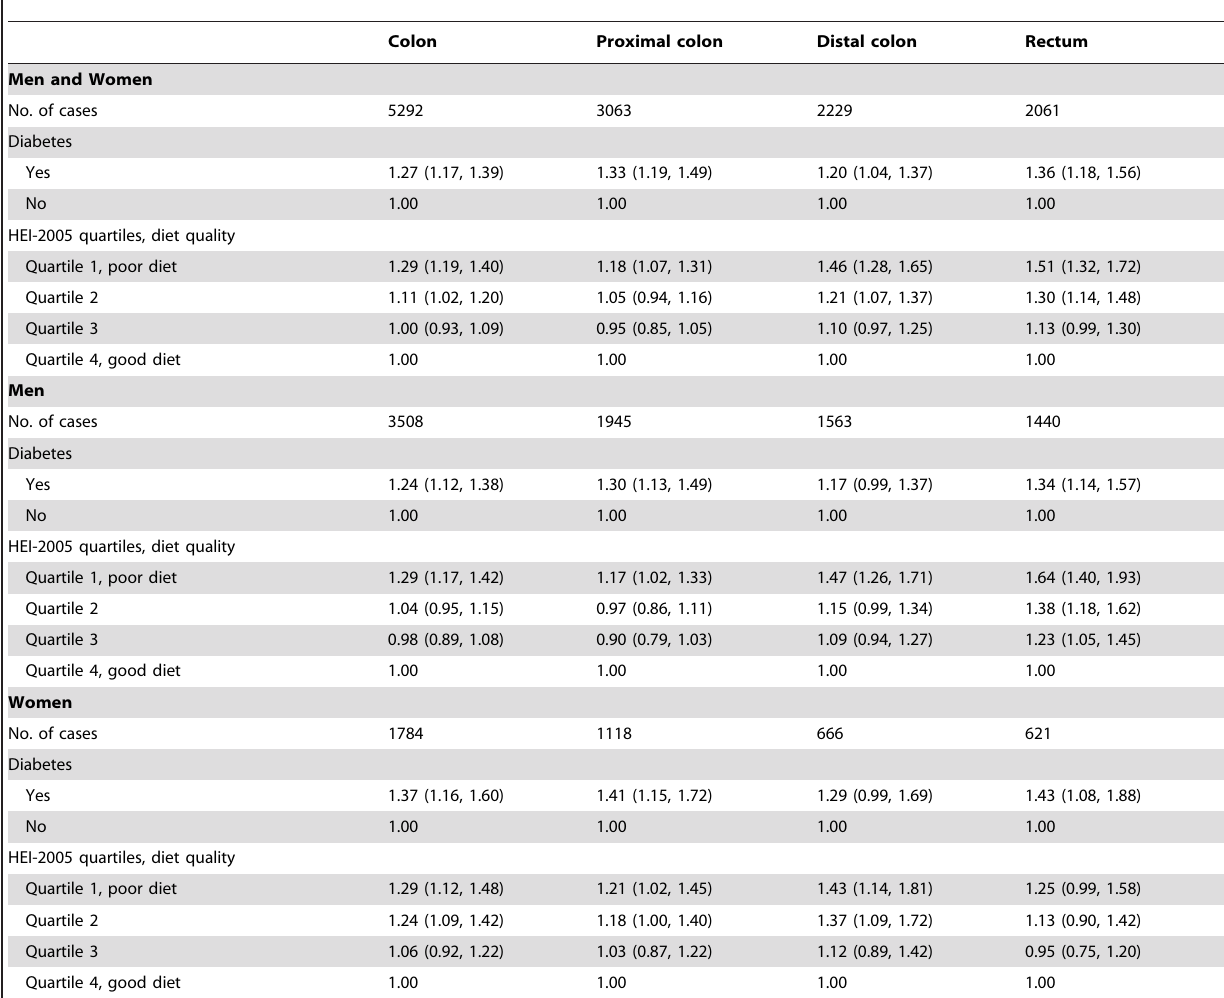
Table 3. Diabetes, Diet Quality and Risk of Colorectal Cancer by